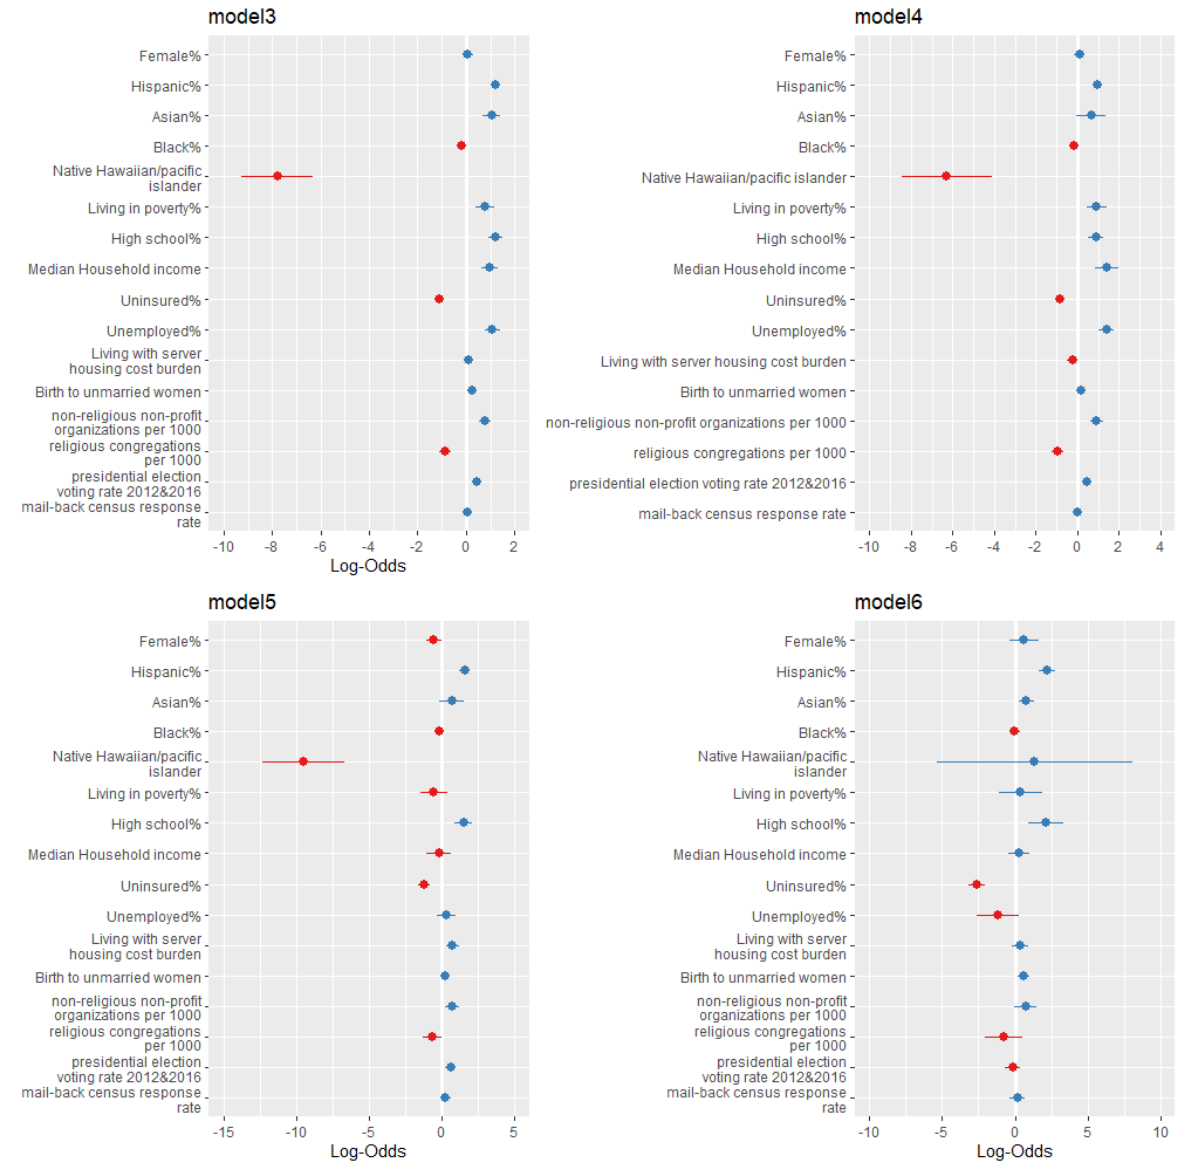
Figure A1. Forest plots of Model 3 to Model 6. Notes: Logarithm of odds ratio was used in developing the forest plots given large value of some odds ratios. We then used zero instead of one as the criteria of significance.